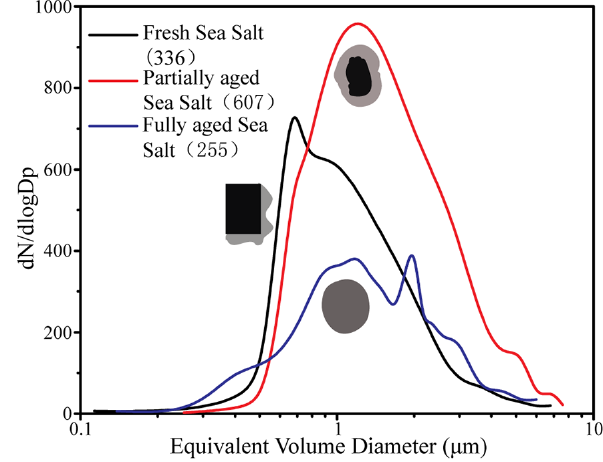
Figure 7. Size distributions of 336 fresh, 607 partially aged, and 255 fully aged SSA collected in Arctic summer. The SSA with di- ameters lower than 100nm were not considered in this